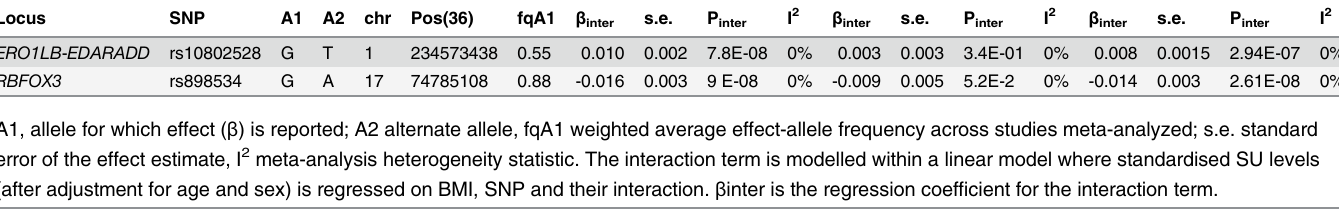
S9 Table. Both RBFOX3 and ERO1L-EDARADD SNPs showed consistent direction of interac- tion effect between discovery and follow-up sets and a low level of heterogeneity across studies and RBFOX3 index SNP reached genome-wide significance in the combined dataset (Table 3).